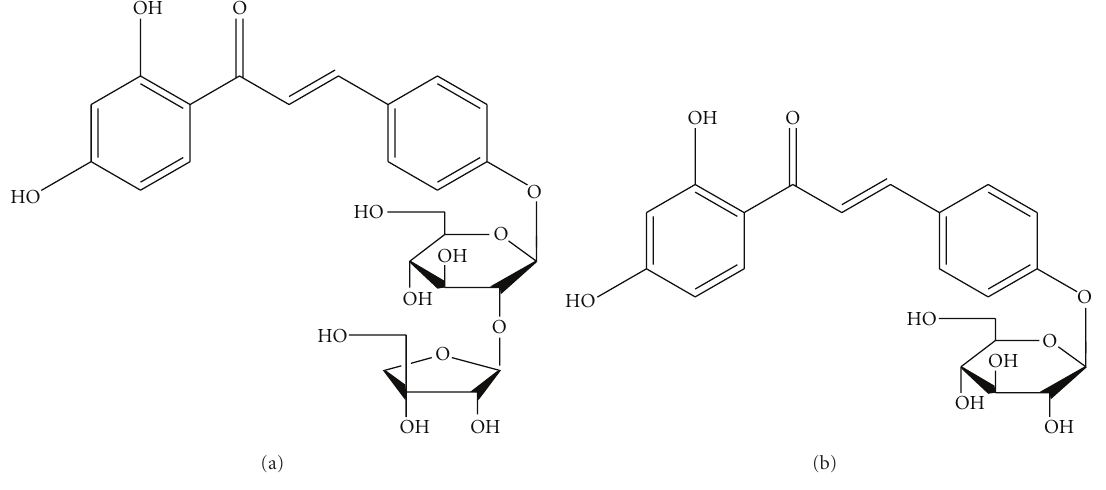
Figure 1: Isoliquiritin apioside (a) and isoliquiritin